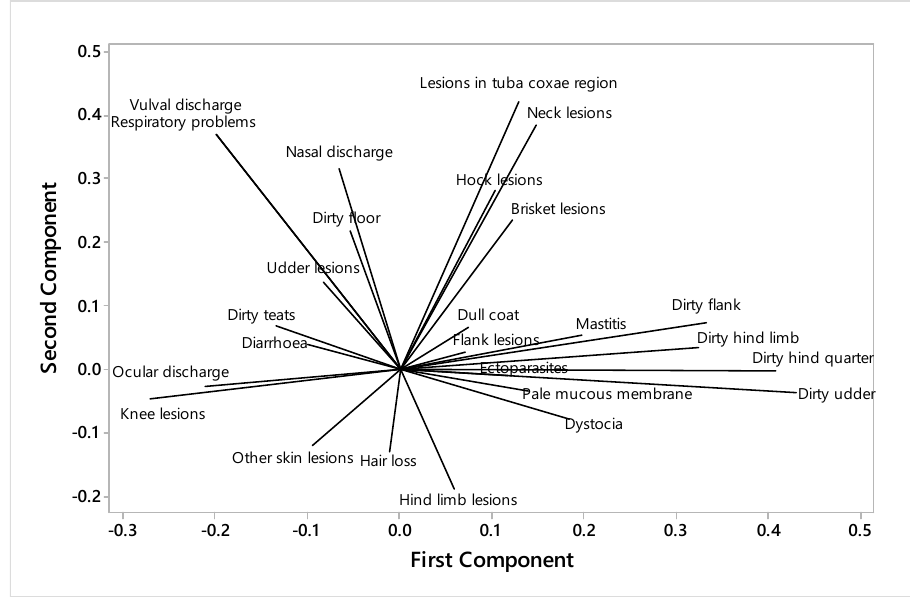
Figure 2. Principal component analysis of health and cleanliness factors of 700 cows in 70 herds in Sirajgonj district,